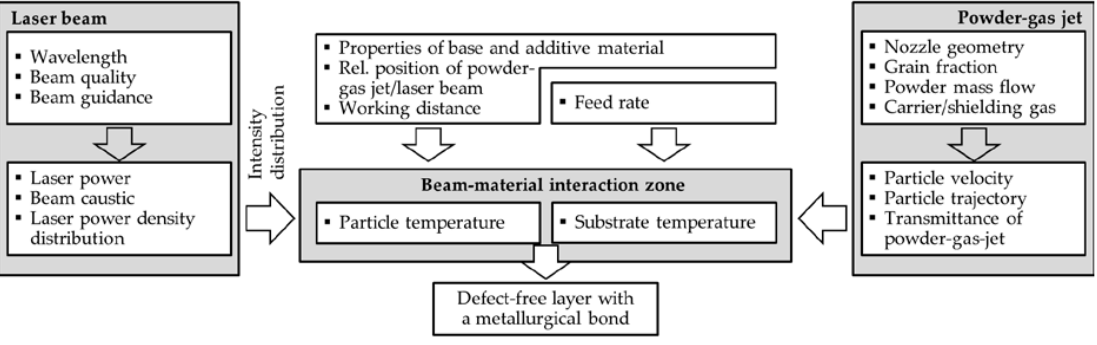
Figure 1. Diagram of the factors influencing powder-based laser material deposition (LMD) [1]. Reprinted with permission from Ref [1]. Copyright 2020, Fraunhofer Verlag.